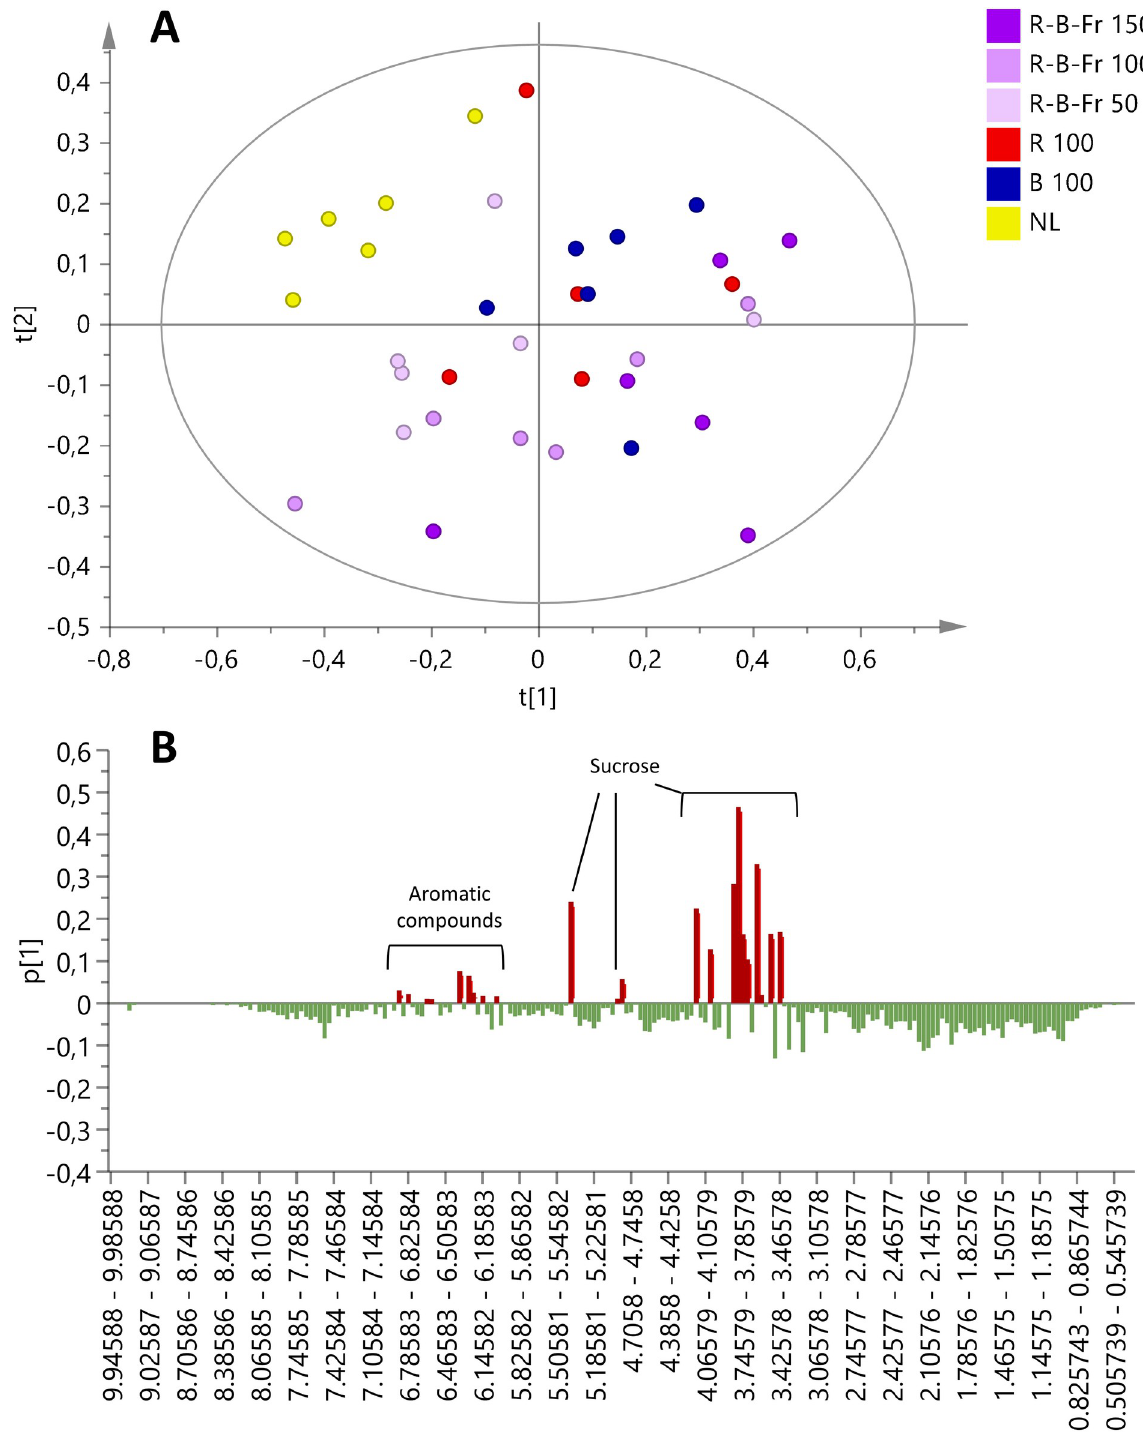
Fig 5. 1 H NMR based principal component analysis of T. baccata samples under different LED light treatments. A) Score scatter plot B) Loading column plot. R 2 (cum) = 0.552, Q 2 (cum) = 0.442.